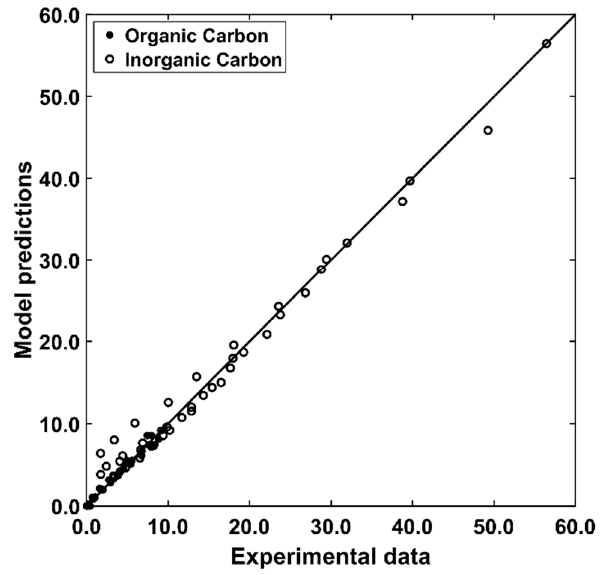
Figure 9. Model validation for total organic carbon and bicarbonate experimental concentrations.